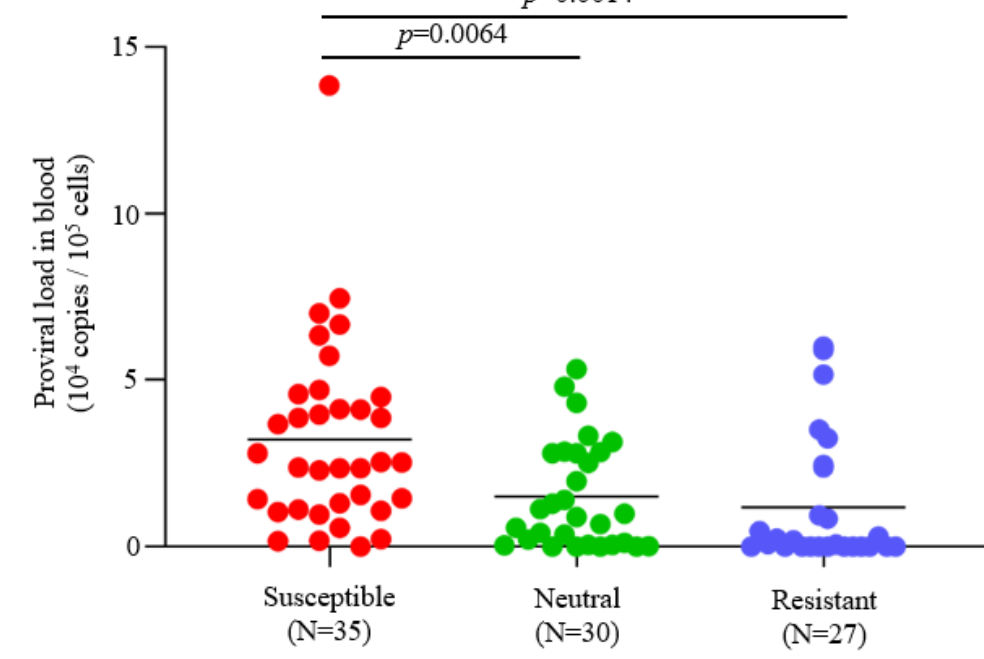
Figure 1. Comparison of proviral load (PVL) in blood from BLV-positive dams. BLV infection was determined by a combination of the BLV Env gp51 specific antibodies detection and provirus detection by BLV-CoCoMo-qPCR-2. Blood samples were obtained from 92 BLV-positive dams and extracted DNAs. The PVLs in blood were measured using the CoCoMo-qPCR-2 method (Nippon Gene, Tokyo, Japan). BoLA-DRB3 alleles were typed by the PCR-SBT method using DNA from blood. All BLV-positive dams were divided into resistant, susceptible, and neutral groups based on the presence of BoLA-DRB3 alleles as follows: susceptible dams carried at least one BoLA-DRB3*012:01 or *015:01 allele in their genomes; resistant dams carried at least one BoLA-DRB3*002:01 , *009:02 , or *014:01:01 allele in their genomes; and neutral dams carried other alleles in their genomes. Dams carrying both susceptible and resistant alleles were defined as resistant. N = number of tested dams. Mean PVL values were compared among groups using Tukey’s multiple comparison test.